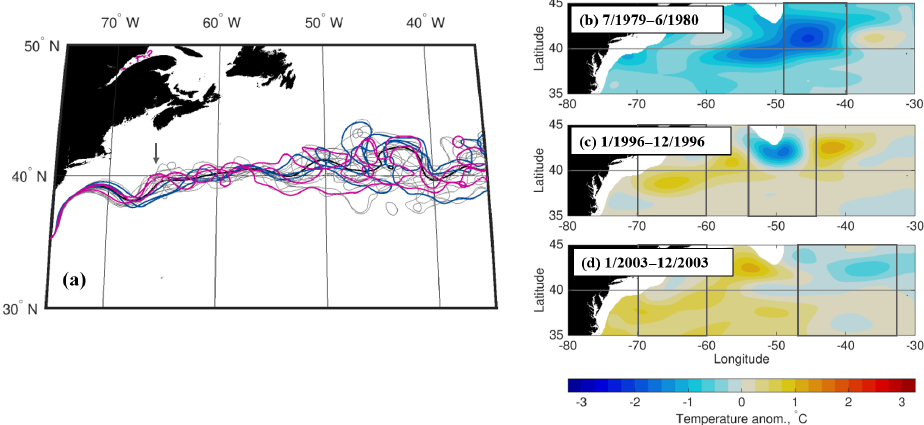
Figure 13. (a) Spaghetti plot showing annual averages of the − 20cm contour path (approximate Gulf Stream path) in POP; magenta lines indicate the path during times of high EKE and MTF, blue lines indicate times of high EKE but low MTF, and gray lines are randomly dis- tributed 1-year average paths during 1978–2009. The arrow indicates a path anomaly associated with the high MTF events. (b–d) Large-scale temperature anomalies, averaged 0–1000m, during the periods of high mesoscale temperature flux. The gray boxes indicate the region(s) in which negative meridional temperature gradients contribute the most to the mesoscale temperature flux.